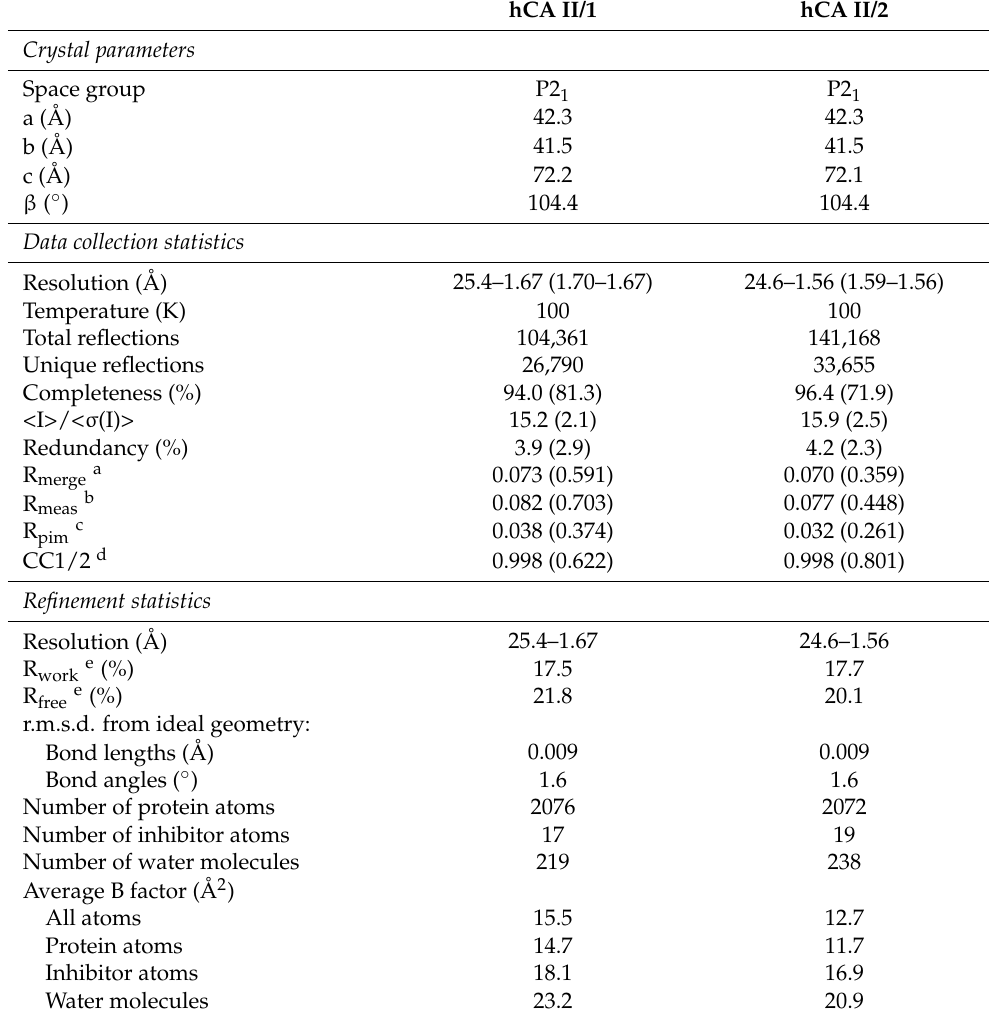
Table 1. Data collection and refinement statistics for hCA II/ 1 and hCA II/ 2